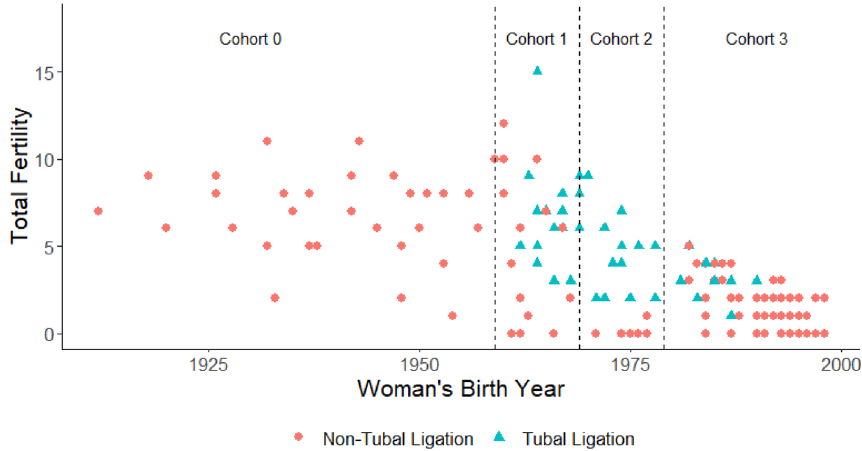
Figure 1. Total fertility across time stratified by women who have (triangles) and have not had a tubal ligation (circles). Dashed lines indicate cohort boundaries. Completed fertility (women > 40 years old) is shown for Cohorts 0–2. Women in Cohort 3 are still of reproductive age (ages 20–39) and values reflect total current fertility (number of live births through 2017).